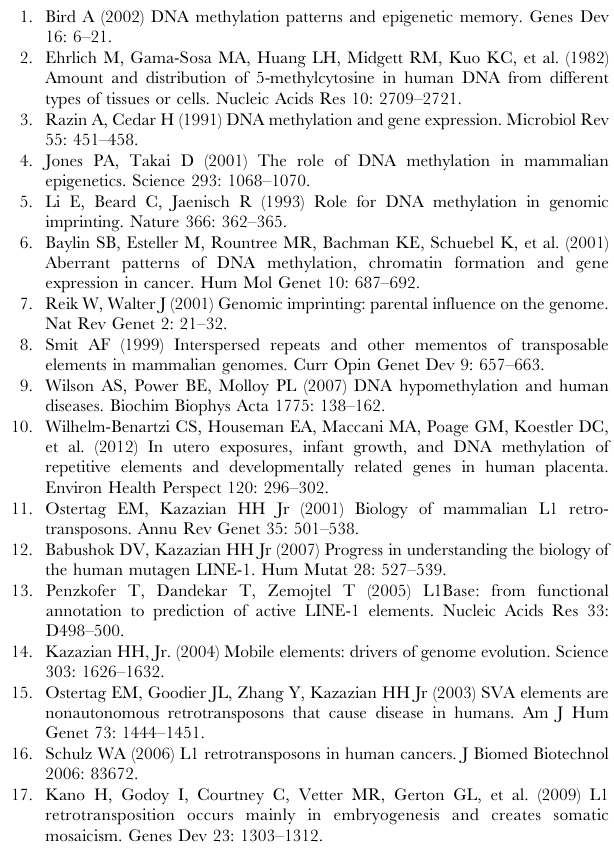
Figure S1 The specificity of real-time PCR. Products from real- time PCR were resolved in 2% agarose gel and DNA bands were